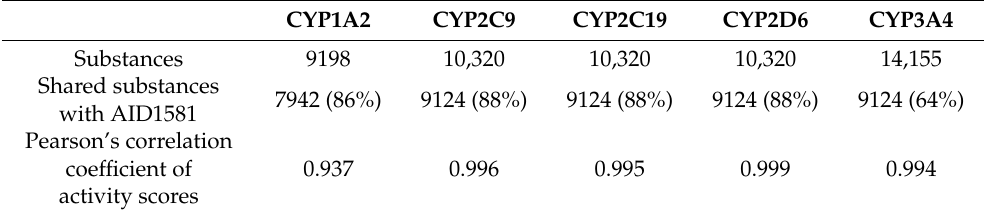
Table 2. Similarity of AID datasets to